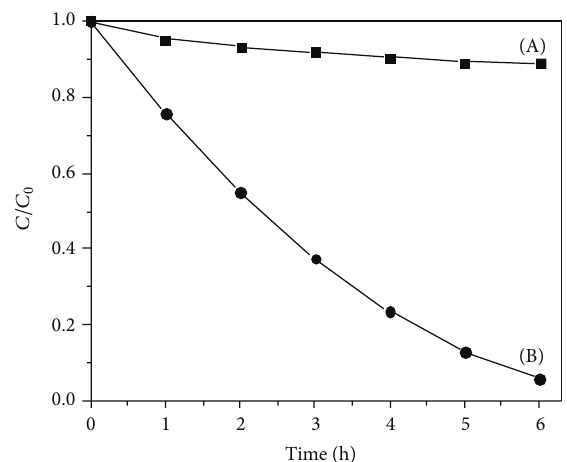
Figure 7: Photocatalytic degradation of methylene blue on TiO 2 - SBA-15 (A) and N-TiO 2 -SBA-15 (B) with initial methylene blue concentration of 100mg/L under visible